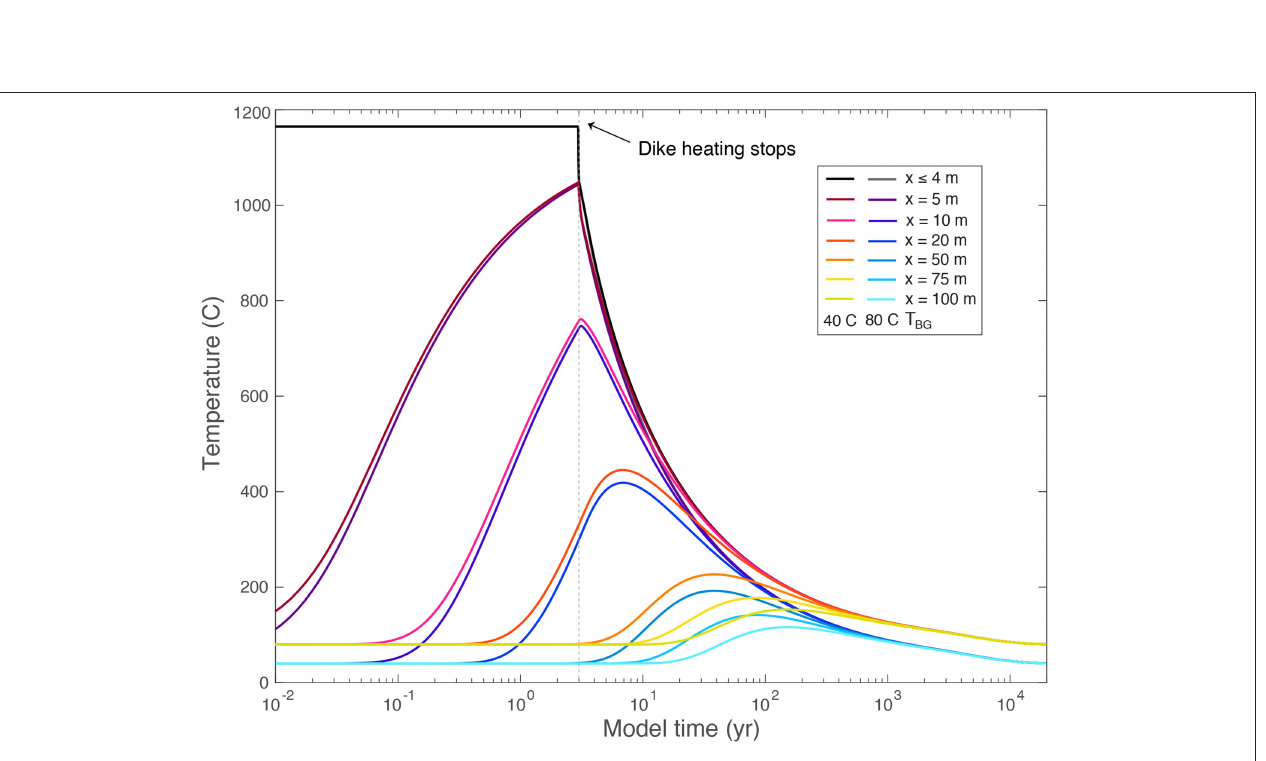
Frontiers in Earth Science | www.frontiersin.org